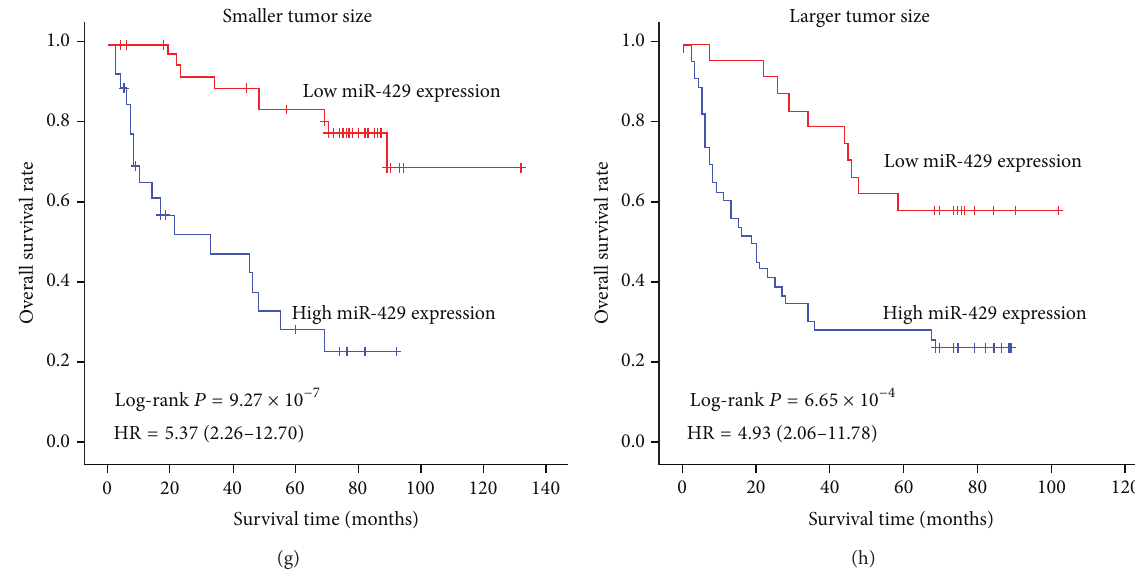
Figure 3: Survival analysis of miR-429 expression in strata of AFB1-DNA adducts and tumor size. ((a)-(b)) Tumor recurrence-free survival (RFS) and miR-429 expression in strata of AFB1-DNA adduct levels. ((c)-(d)) Overall survival (OS) and miR-429 expression in strata of AFB1-DNA adduct levels. ((e)-(f)) RFS and miR-429 expression in strata of tumor size. ((g)-(h)) OS and miR-429 expression in strata of tumor size. Cumulative hazard function was plotted by Kaplan-Meier’s methodology, and 𝑃 value was calculated with two-sided log-rank tests. Relative hazard ratio (HR) and corresponding 95% CI of high miR-429 expression (compared with low expression) were calculated using multivariable cox regression model (including all significant variables).